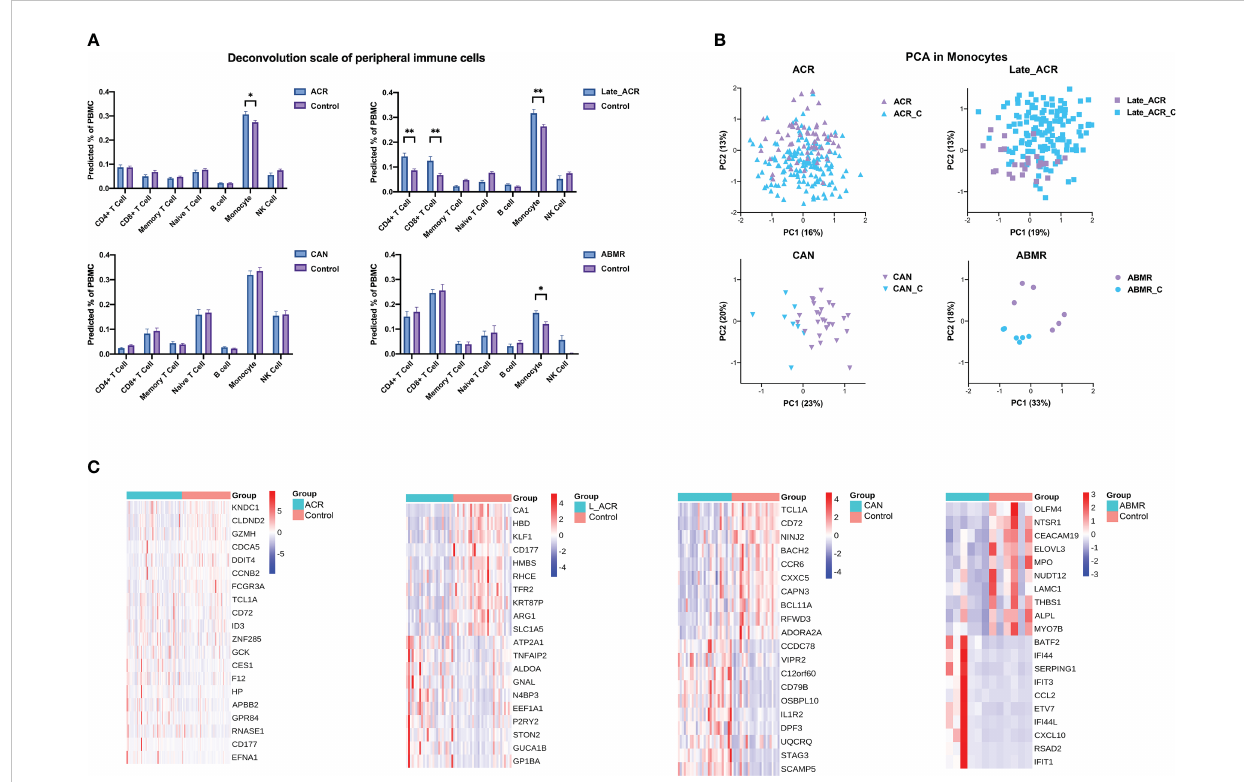
FIGURE 4 The cell type percentage and gene expression from bulk-RNA seq of rejected and control PBMC deconvolution by BayesPrism. (A) The cell type percentage between each rejection group and the control group. (B) Principal component analysis indicated the unde fi ned gene expression signature of monocytes in ACR, late ACR, CAN and ABMR group. (C) Clustering heat maps demonstrate expression levels of 20 robust DEGs of monocytes in different rejection samples. *p < 0.05 **p <